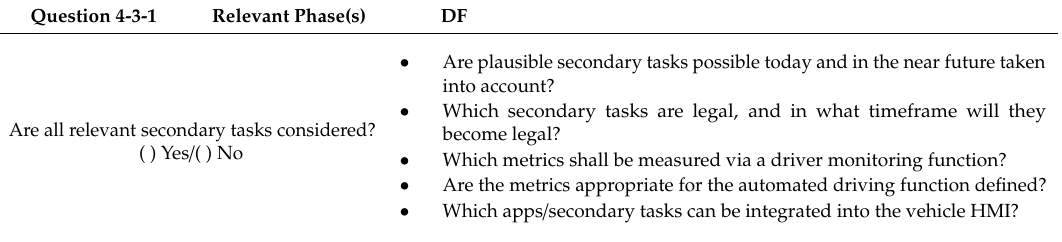
Table 6. Example question on Driver